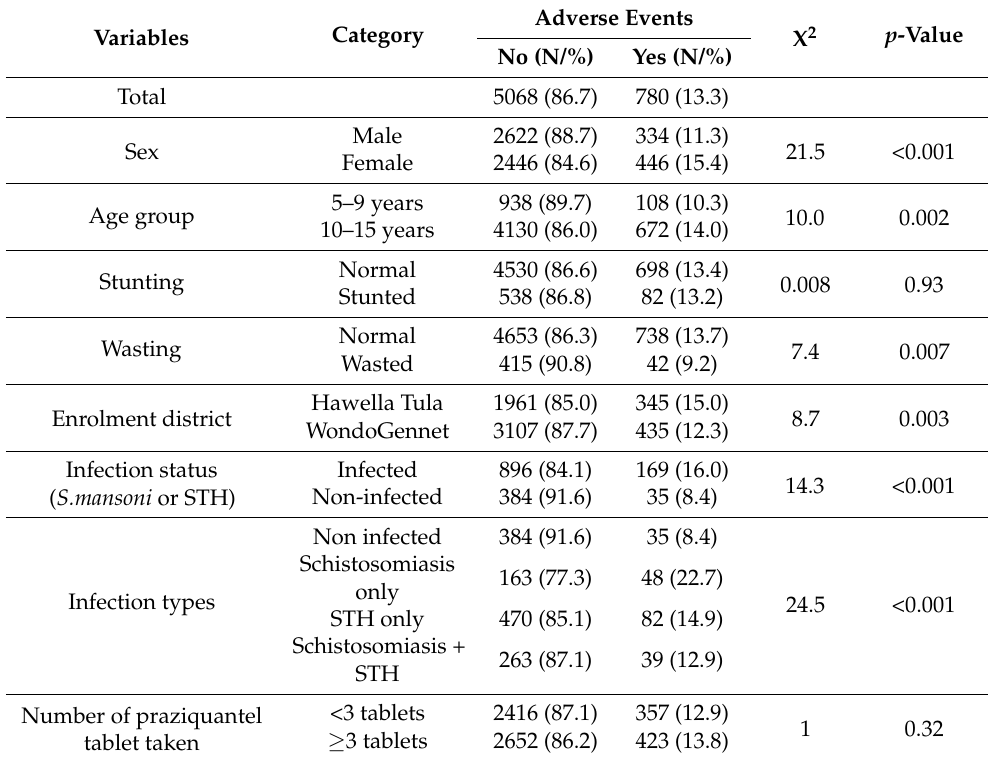
Table 3. Cumulative incidence AEs following mass praziquantel and albendazole administration and associated